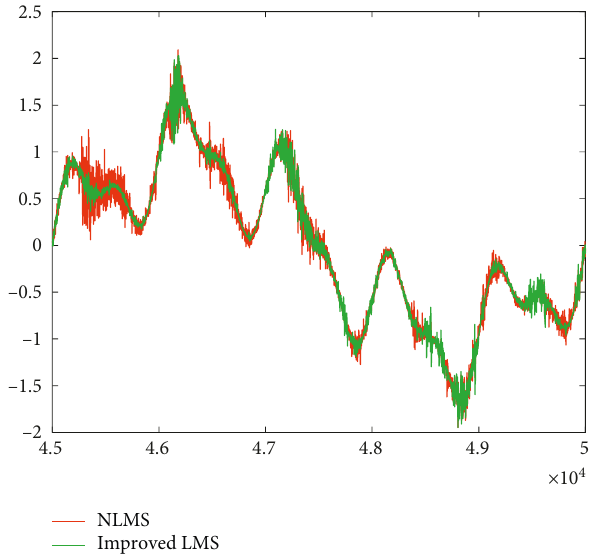
Figure 4: Local comparison of the NLMS algorithm and the improved LMS